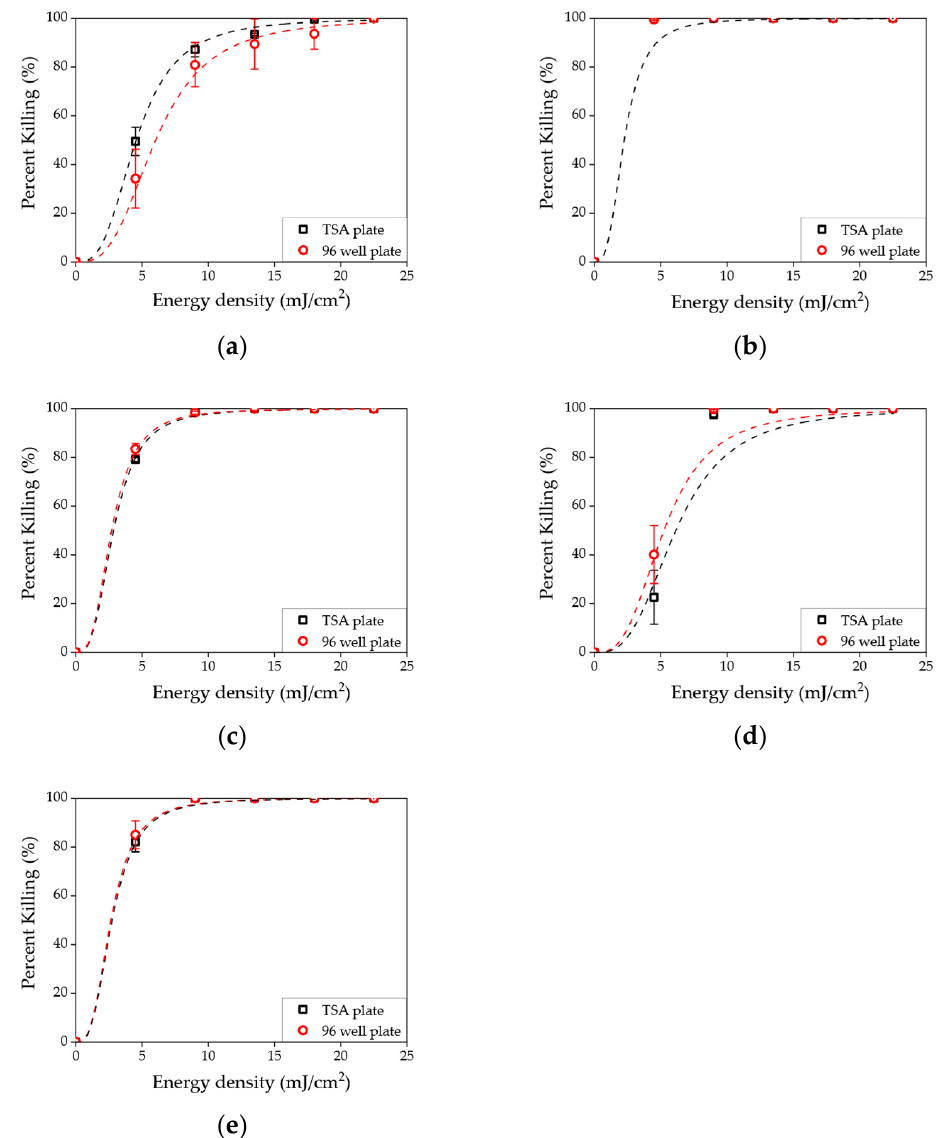
Figure 5. Killing rate as a function of energy density in a liquid sample (black rectangle) and nutrient-rich agar media (red circle) for ( a ) E. coli , ( b ) K. pneumoniae , ( c ) S. enteritidis , ( d ) L. innocua , and ( e ) S. aureus .